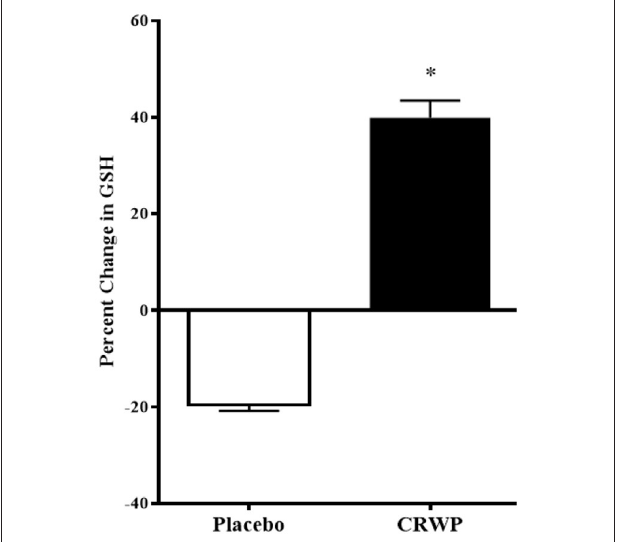
FIGURE 3 | Percent change from baseline of reduced glutathione levels in placebo and CRWP groups. * p < 0.05. CRWP, cysteine-rich whey protein.